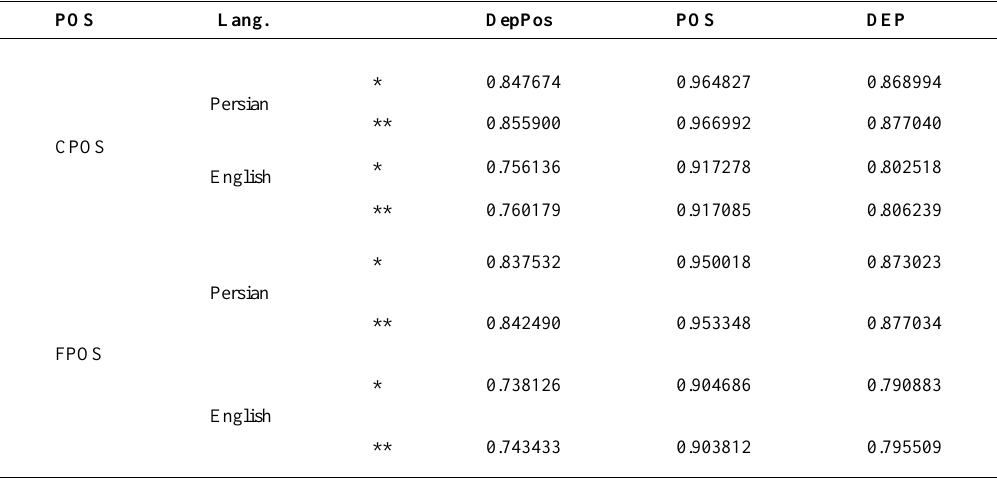
Table 9. Joint model accuracy on test dataset with 10 iterations before and after features